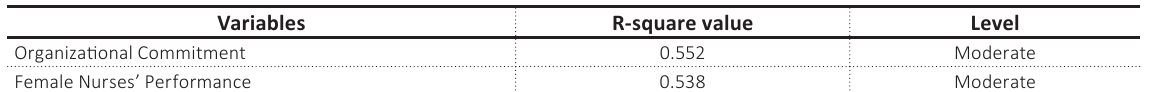
Table 4. R-Square